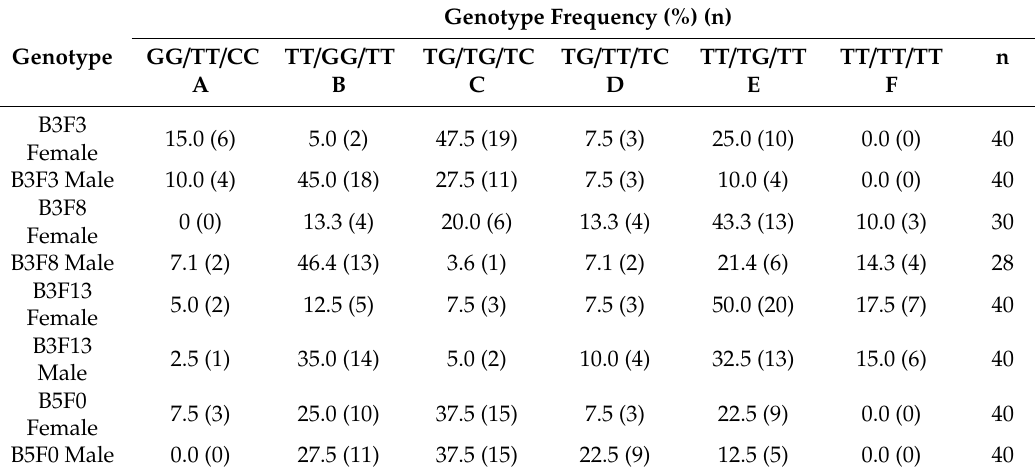
Table 5. Comparison of Vssc mutations across four generations of the IMR colony of Aedes aegypti (B3F3, B3F8, B3F13, B5F0) (order of mutation sites: 1016 / 1534 /